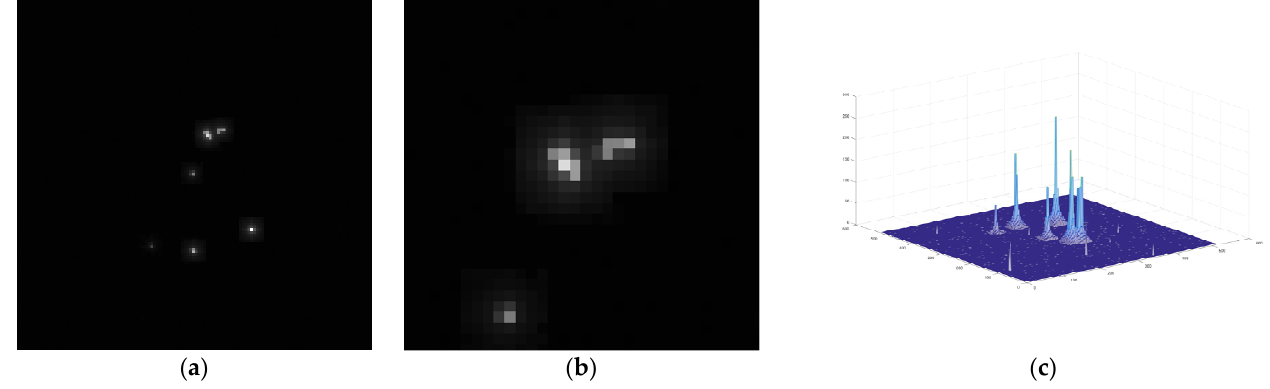
Figure 2. ( a ) Infrared image of extended targets; ( b ) Enlarged image of two close extended targets; ( c ) The amplitude of targets and clutter. ( c ) The amplitude of targets and